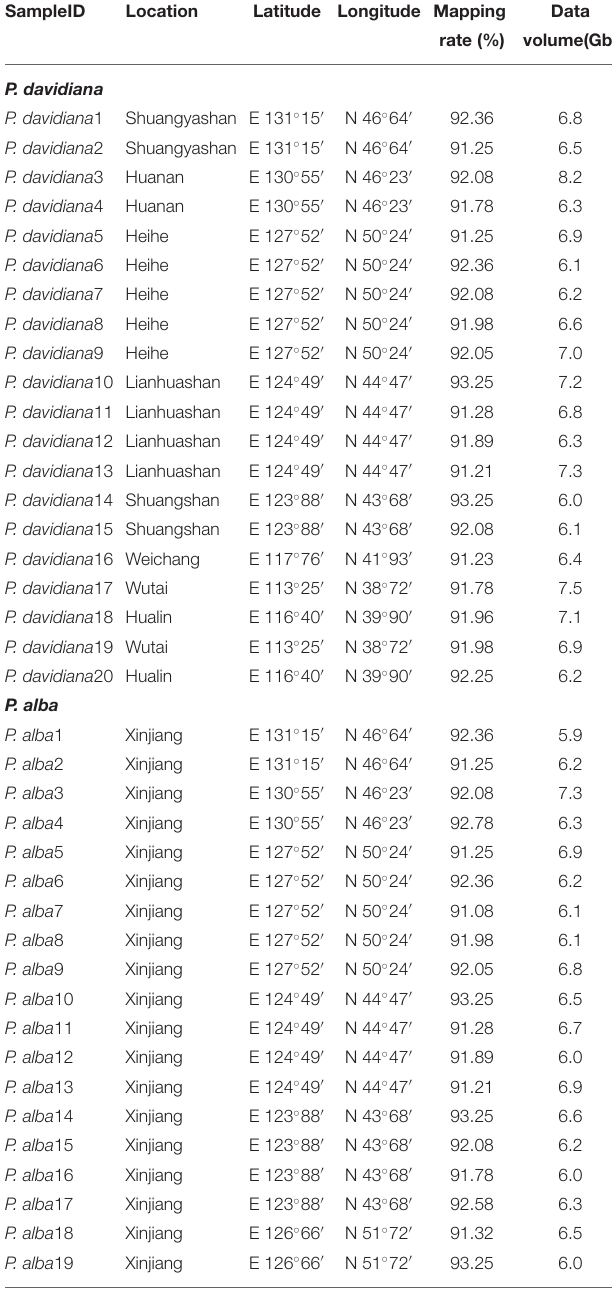
TABLE 1 | Statistics summary of Illumina re-sequencing data per sample. SampleID